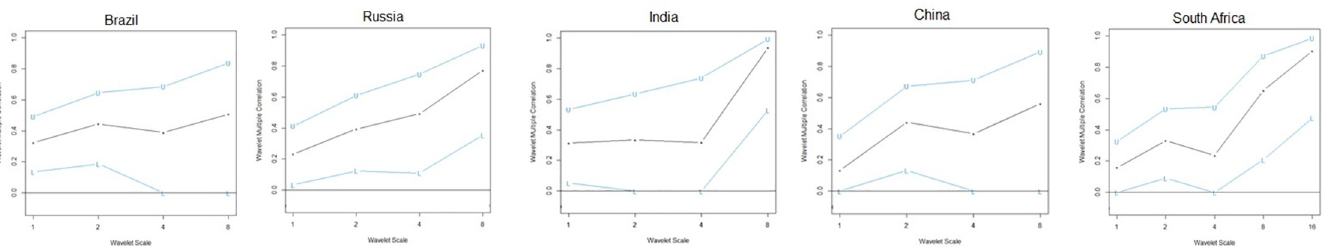
Fig 4. Wavelet multiple correlations among FSI, GDP and GEPU in BRlCS. U-upper limits, L- lower (at 95% confidence interval).